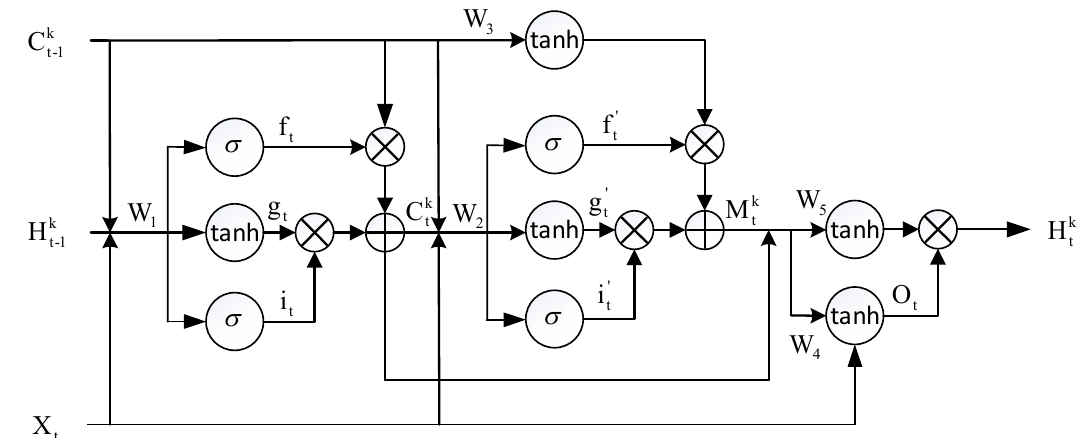
Figure 3. Causal LSTM in which spatio-temporal memories are connected in cascade through gated structures.